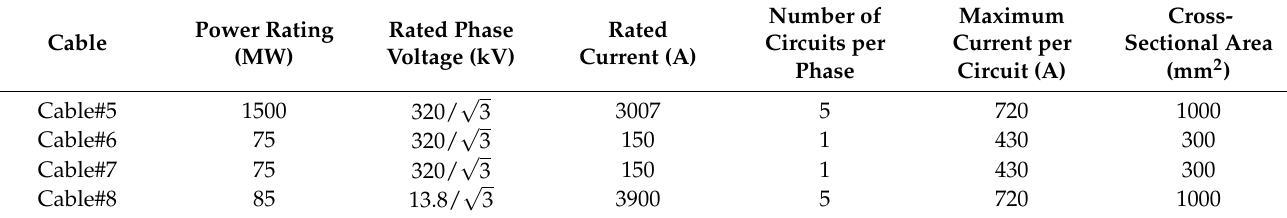
Table A3. Cables design for Architecture 2.